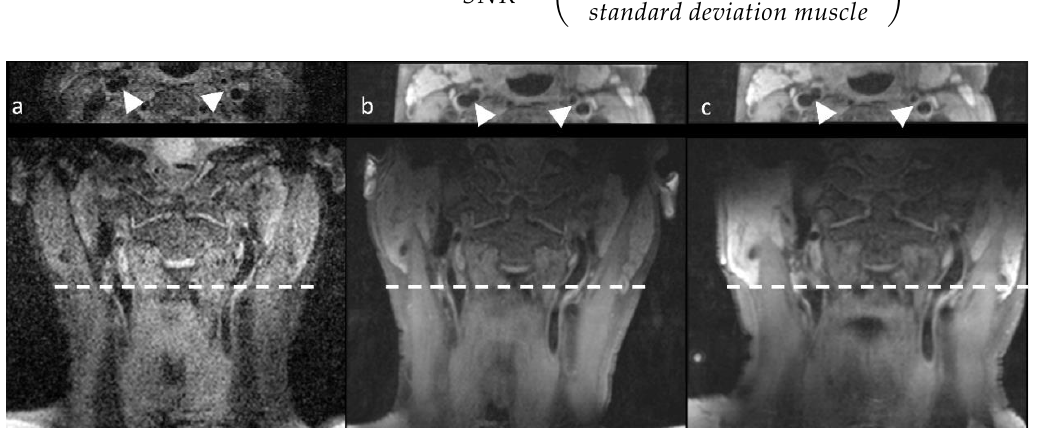
Figure 3. 3D T1-weighted SPACE transversal and coronal views acquired with the three configura- tions of the carotid bifurcation. The upper panel shows transversal images, while the lower panels show coronal images. ( a ) No surface coil, ( b ) MRI-only coil, and ( c ) PET/MRI coil. White arrows in the transversal images indicate the left and right carotid arteries.